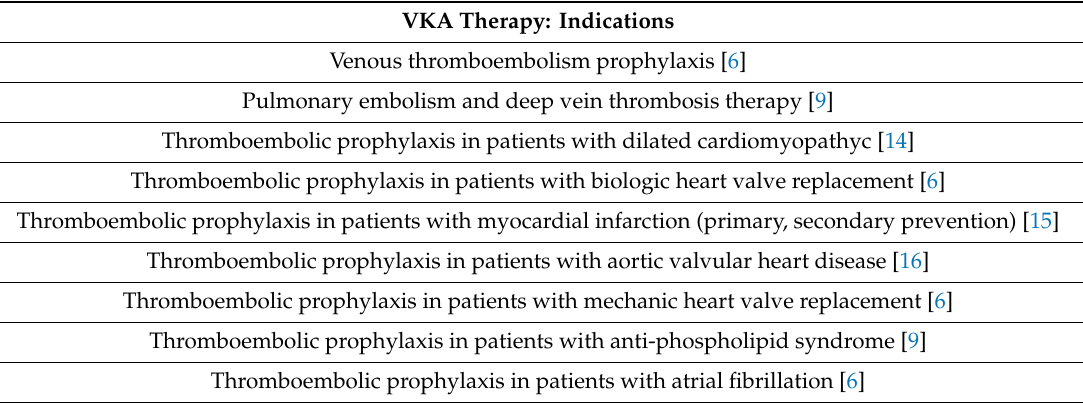
Table 1. Vitamin K antagonists therapy: indications. VKA Therapy: